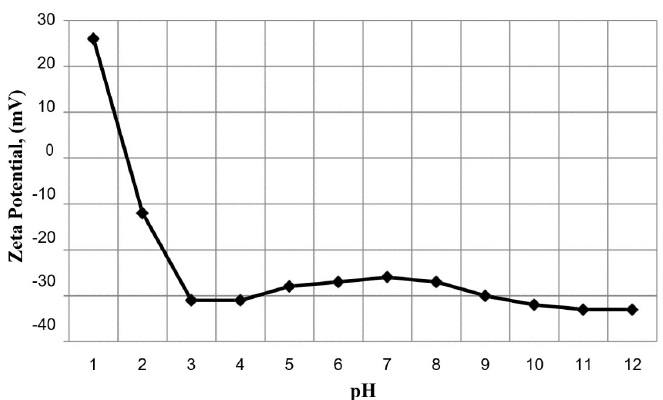
Figure 7. Zeta potential of oil droplets as a function of pH. Membranes 2020 , 10 , x FOR PEER REVIEW